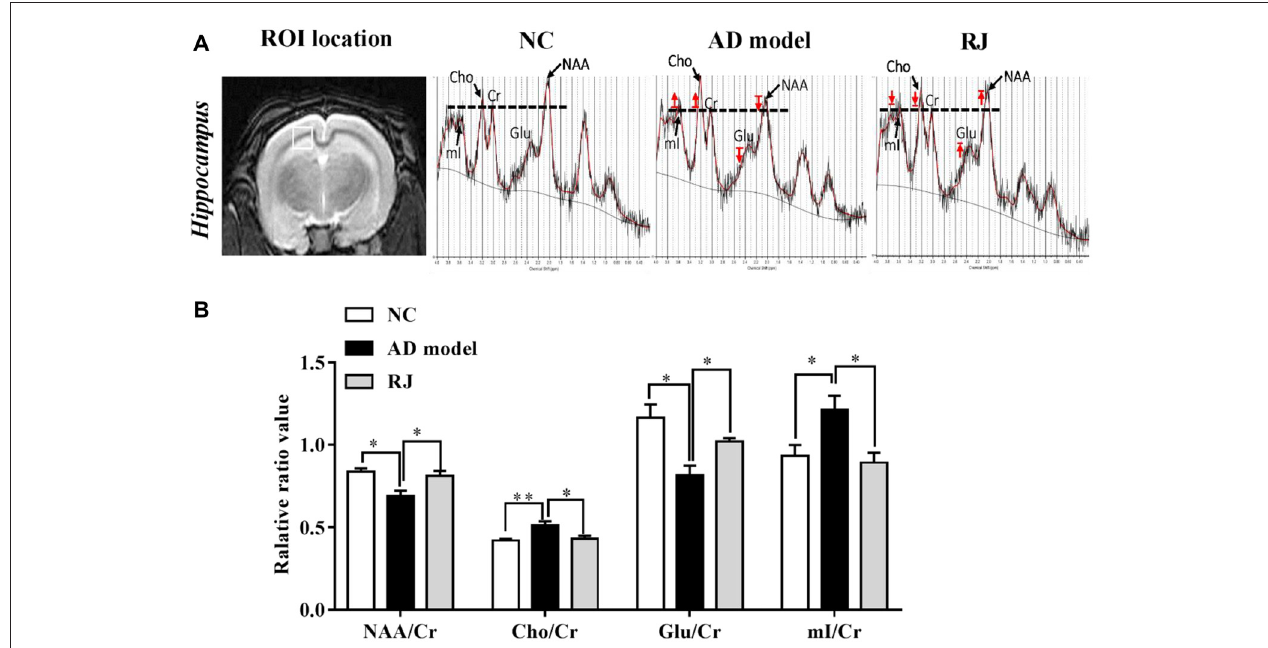
FIGURE 7 | RJ improved brain metabolic activities in AD rabbits. (A) Regions of interest (ROI) location in the brain (white box) and representative spectra from the AD model, RJ and NC group rabbits. The red arrow indicates direction of metabolic changes, and the line represents the control level of each metabolite. (B) The relative ratios of each metabolite to creatine (Cr) in the brain of the three groups, n = 6 rabbits per group. Data are presented as mean ± SEM. ANOVA with post hoc Tukey’s test was used. ∗ P < 0.05, ∗∗ P < 0.01 vs. the AD model